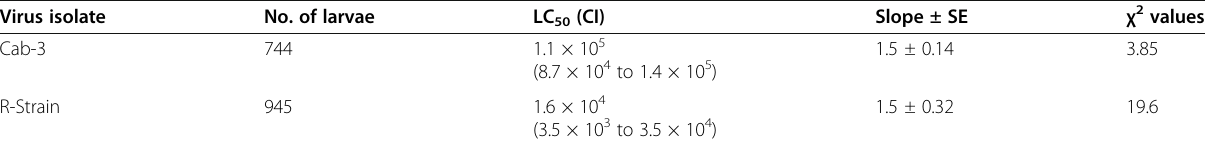
Table 1 Median lethal concentration (LC 50 ) values for 1st larval instar of Spodoptera littoralis infected with OBs derived from SpliMNPV isolates 7 days post infection.